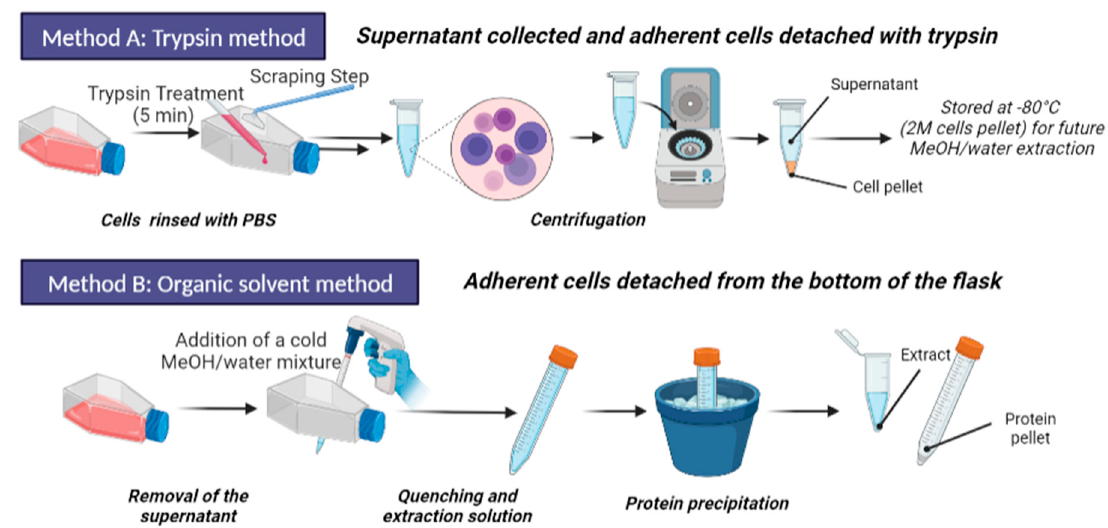
Figure 2. Schematic representation the two evaluated sample preparation methods. Activated (adherent) cells were harvested from the flasks by using trypsin, recovered by scraping, and then lyzed by using MeOH/water mixture (Method A). In parallel, on a culture replicate, adherent cells were directly treated with MeOH/water for simultaneously quenching metabolism, lysing cells, and extracting metabolites (Method B). The cell lysates were analyzed by UHPLC-HRMS for metabolome profiling. Figure made with BioRender.com.